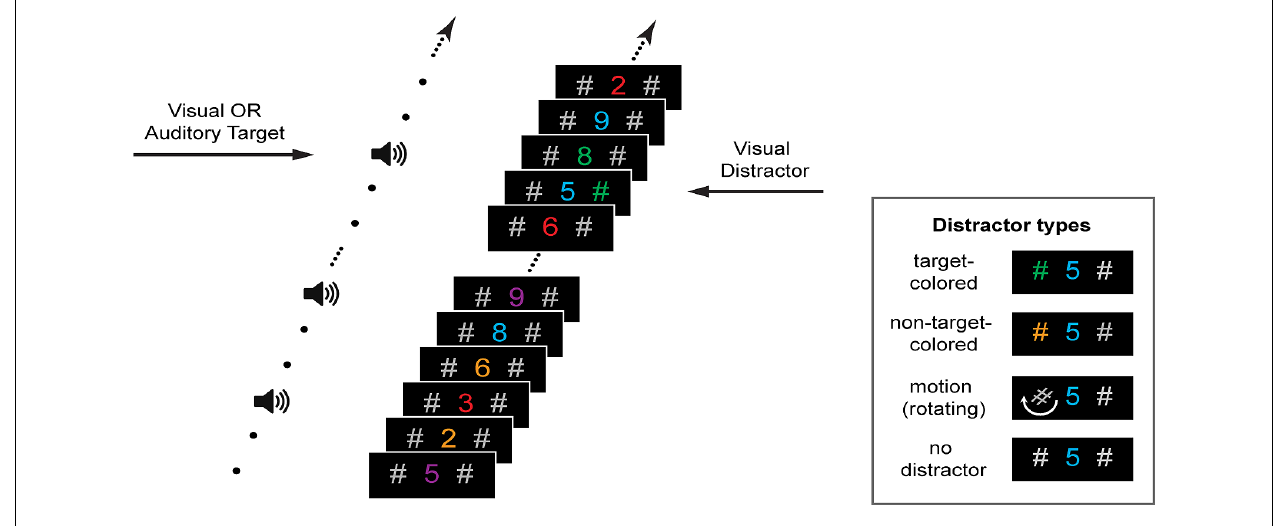
FIGURE 1 | Stimuli and trial design. Participants fixated a central stream of rapidly presented digits and listened to tones. Their task was to detect either a number presented in a pre-defined color or a change in the tonal frequency. Prior to the presentation of a visual or auditory target (50%